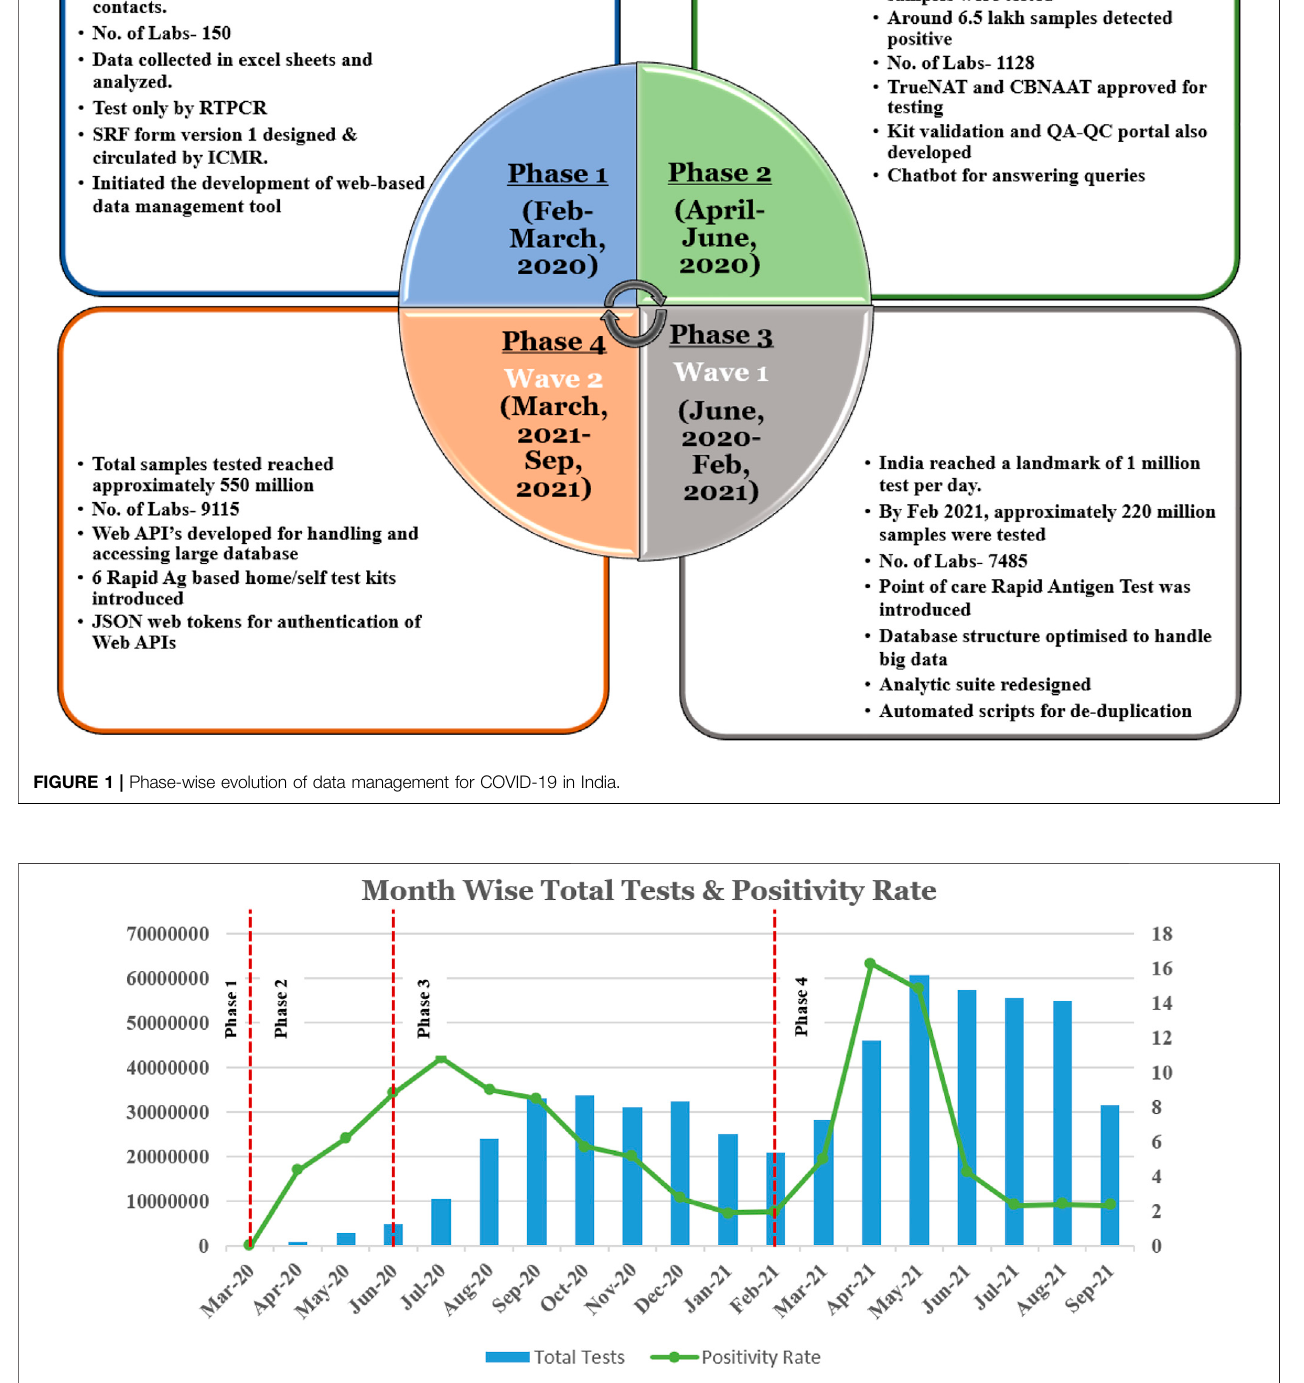
Frontiers in Big Data |